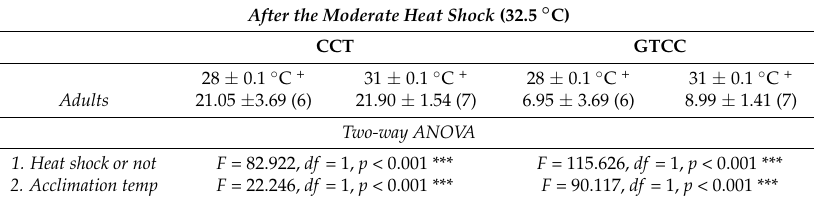
Table 3. Results of moderate heat shock experiments after acclimation for 24 h. Cool coma temperatures (CCTs) and gap temperatures for cool coma (GTHCs) were measured in adults Halobates germanus . Moderate heat shock was induced for 12 h to 32.5 ± 1.0 ◦ C before acclimation to 28 ± 0.1 ◦ C or 31 ± 0.1 ◦ C. Experiments were performed in December 2016 during the MR16-08 cruise in wet laboratory 2 of the R/V